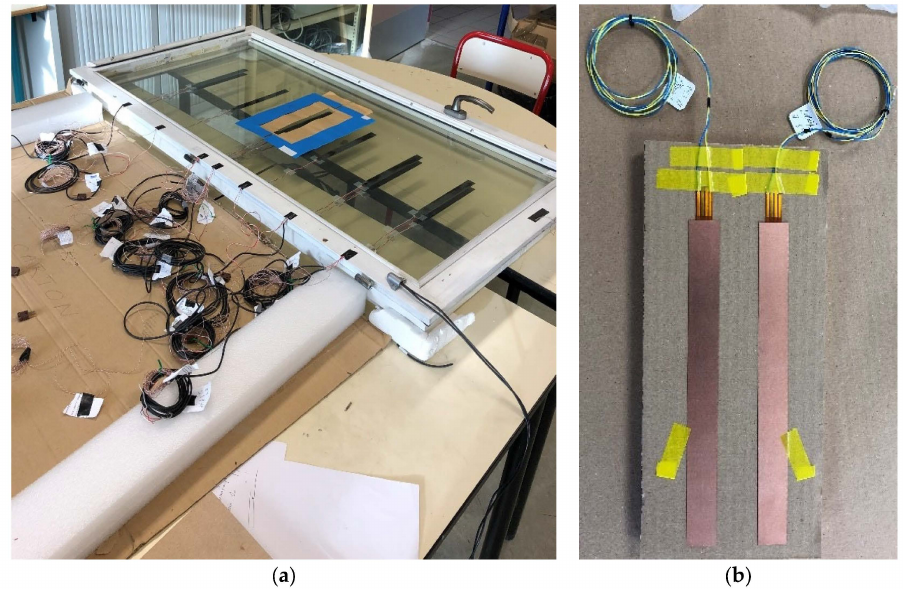
Figure 2. Instrumentation of the parietodynamic window: ( a ) Installation of heat flux and temperature sensors; ( b ) Heat flux sensors before